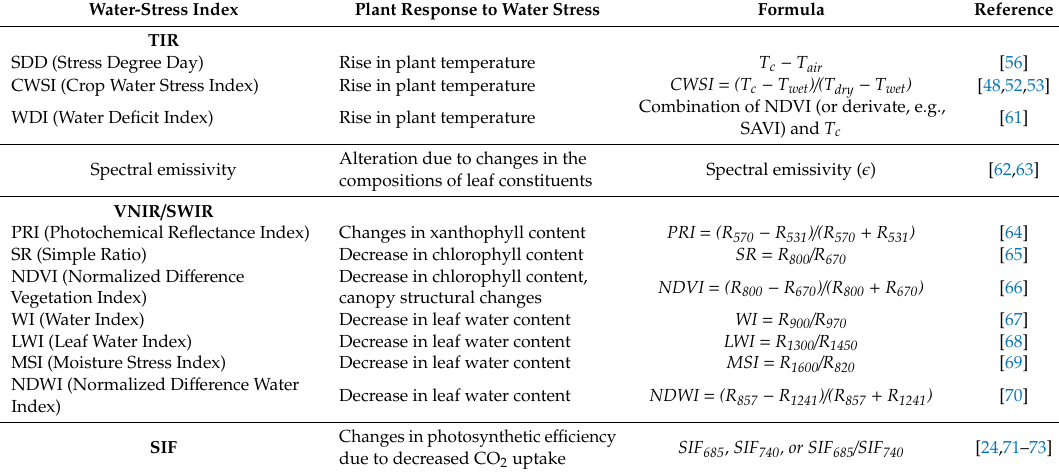
Table 1. A selection of commonly applied indices and approaches for water-stress detection using the main multi- / hyperspectral remote sensing imaging techniques: TIR, VNIR / SWIR, and